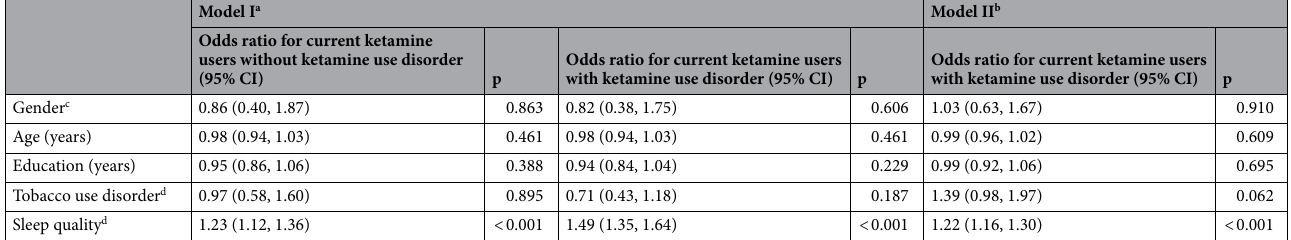
Table 2. Associations between sleep quality and ketamine use status in community ketamine users according to multinomial and binary logistic regression. a Multinomial logistic regression using healthy controls as the reference group; b binary logistic regression using current ketamine users without ketamine use disorder as the reference group; c female as the reference; d: measured by the PSQI; d participants without tobacco use disorder as the reference.